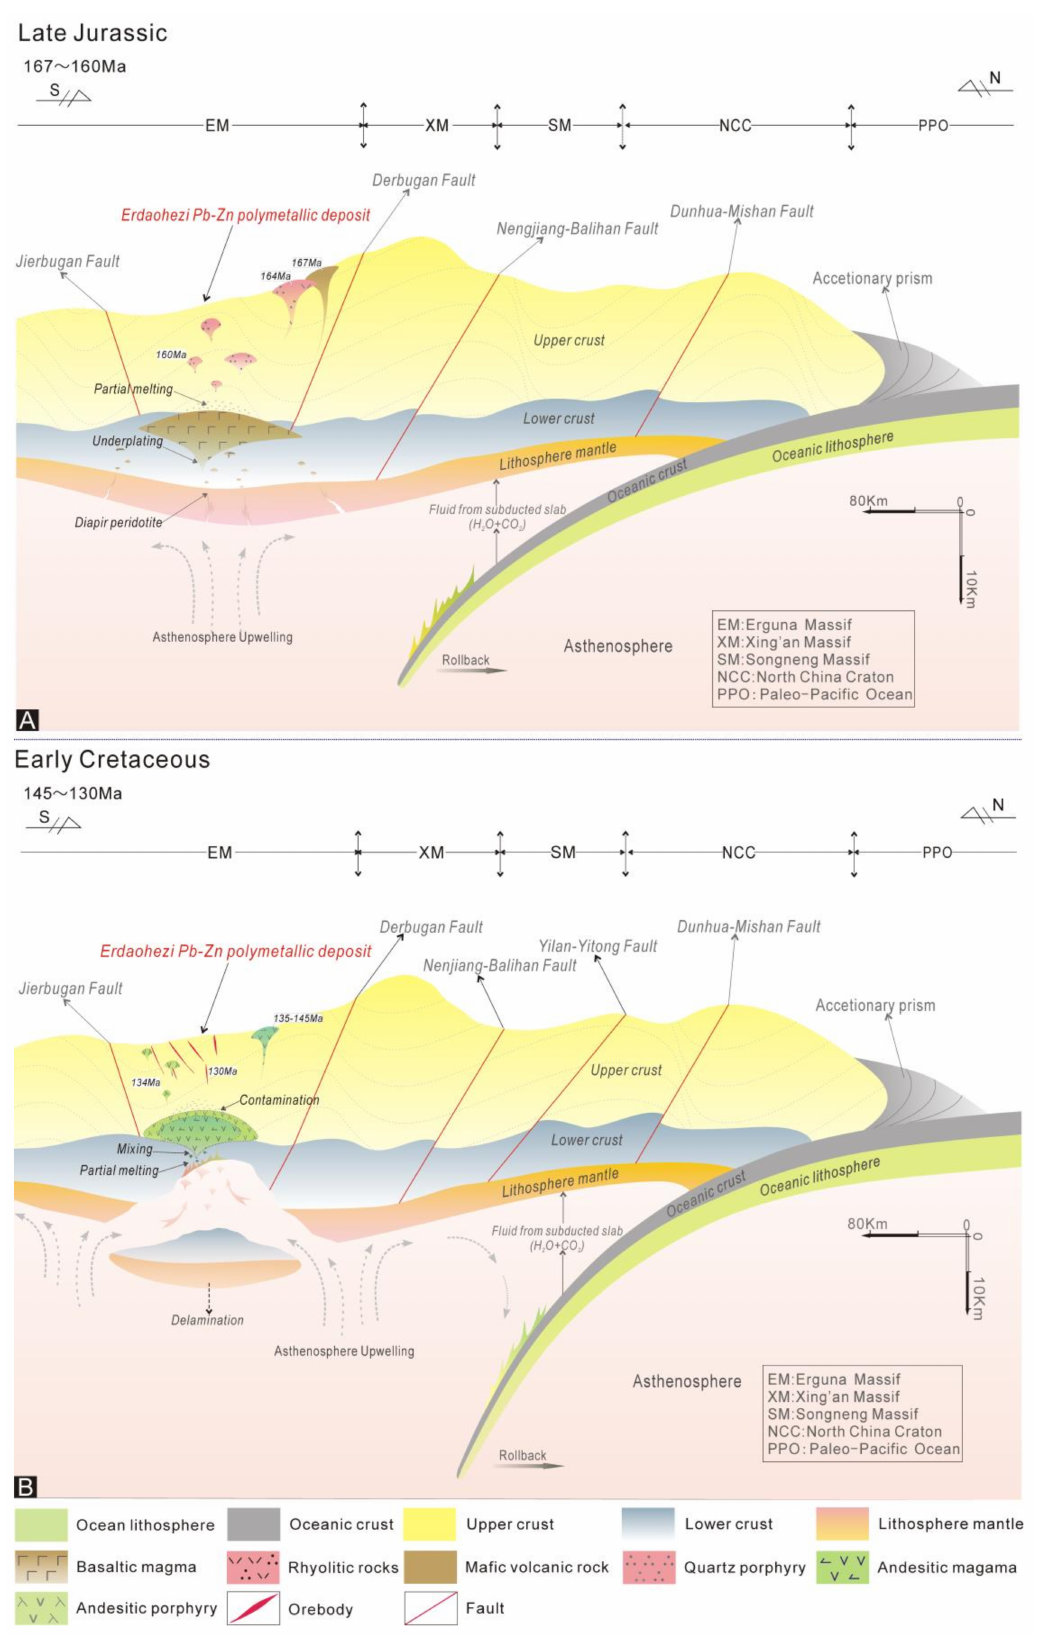
Figure 11. Genetic model and tectonic setting for the Late Jurassic quartz porphyry ( A ), and Early Cretaceous andesite porphyry ( B ) in the